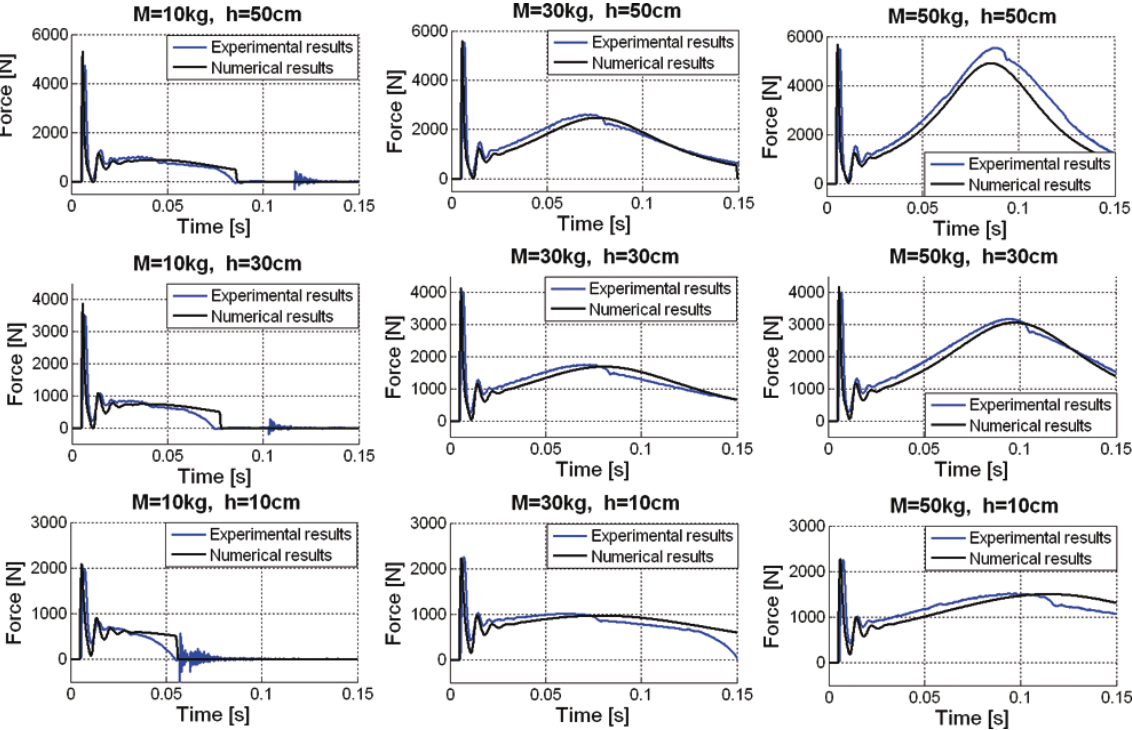
Fig. 5. Comparison of experimental and numerical results of contact force in time domain (initial pressure equal 200